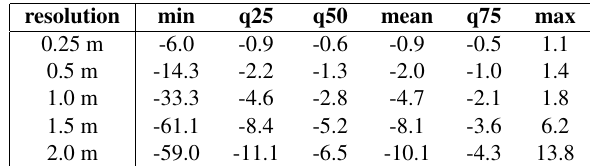
approach the relative error for 90 % of the buildings is within a range from -39.8 % (5 %-quantile) to -1.4 % (95 %-quantile) at a resolution of 2 . 0 m respectively -3.3 % (5 %-quantile) to -0.1 % (95 %-quantile) at a resolution of 0 . 25 m . For the new approach